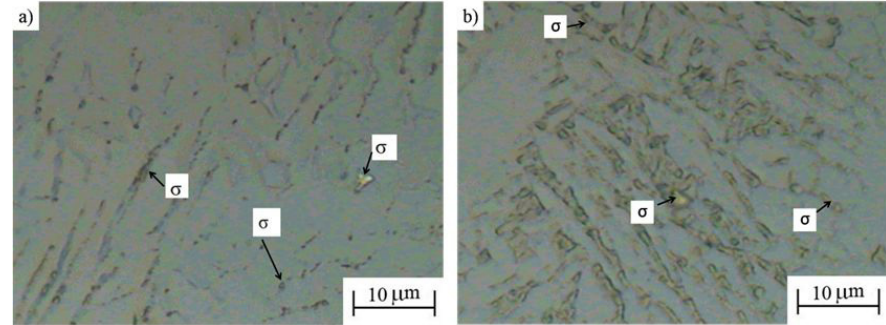
Figure 7. Microstructures of WJ1-WMC obtained by metallographic replica. (a) 15 and (b) 60 minutes. Reagent: KOH.